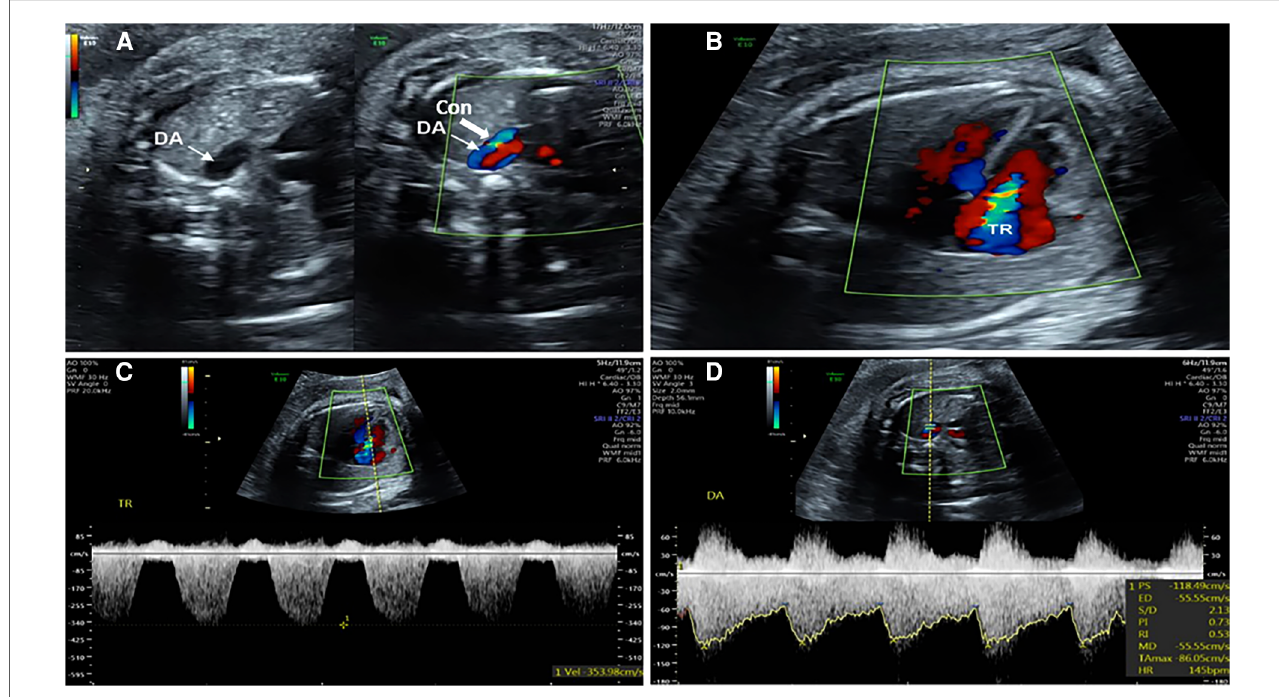
FIGURE 1 Echocardiograms of the fetuses with ductus arteriosus premature contraction (DA Con). ( A ) Narrowed ductus arteriosus; ( B ) Full-systolic tricuspid regurgitation (TR) on four-chamber view; ( C ) Velocity of TR; ( D ) Blood fl ow velocity and pulsatility index (PI) value of DA